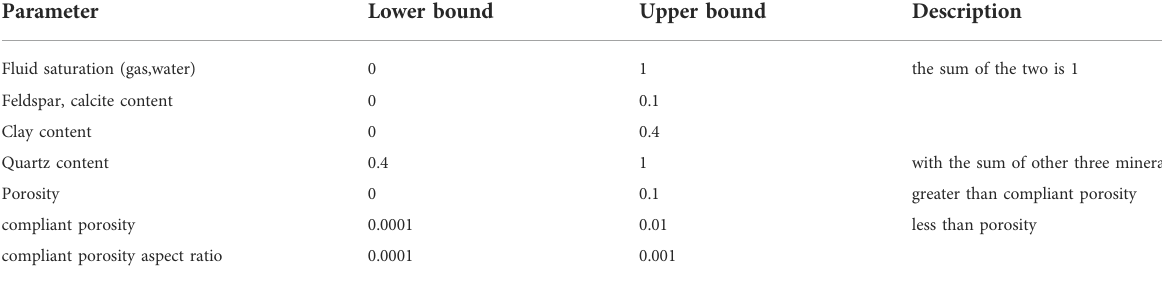
TABLE 2 Sampling range of tight sandstone model